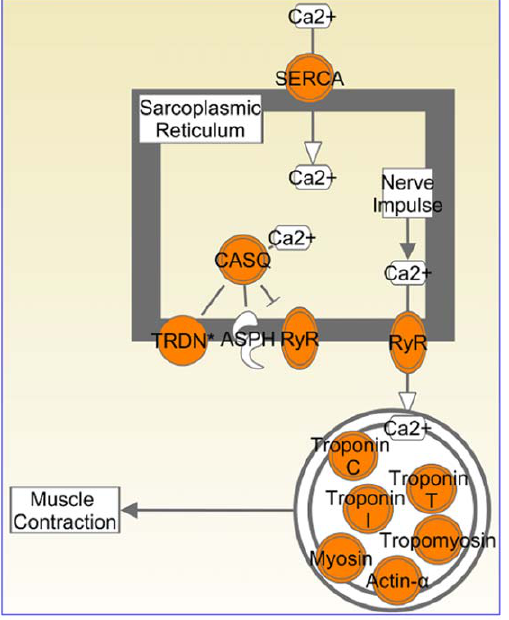
Figure 9. Heart and muscle genes enriched in calcium signalling – muscle contraction pathway. IPA analysis of the top 100 probe-sets from heart and muscle gene clusters (Figure 7) showed the enrichment of calcium signalling pathway. In this figure, we have highlighted the genes present in this pathway in orange. Though this pathway is generalised for skeletal muscle contraction and cardiac muscle contraction, they differ in the members of the same gene family. The heart and muscle genes present in this pathway are given in Tables 7 and 8. Pathway diagram was drawn using Path Designer function of IPA